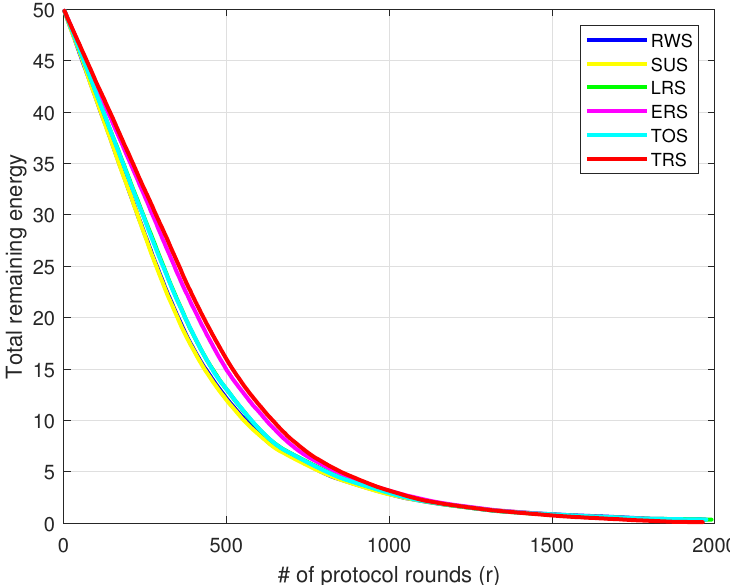
Figure 4. Network remaining energy for the six selection operators.